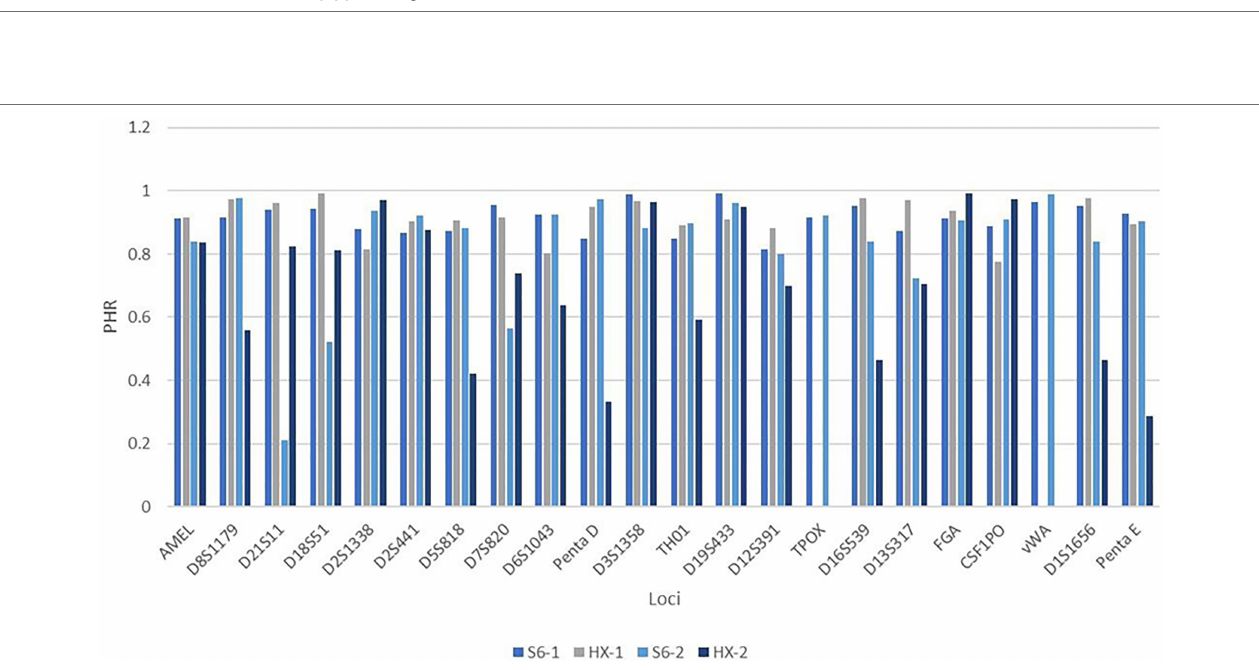
FIGURE 4 | The heatmap showed the height of the lowest peak of each locus when 9948 and 9947A were mixed with the following ratios: 1:4, 4:1, 1:9, and 9:1. (A) Peak heights under 2,000 RFUs were exhibited when 9948/9947A ratios were set at 1:4 and 1:9; (B) peak heights of all loci were exhibited when 9948/9947A ratios were set at 1:4, 1:9, 4:1, and 9:1; (C) peak heights under 2,000 RFUs were exhibited when 9948/9947A ratios were set at 4:1 and 9:1.